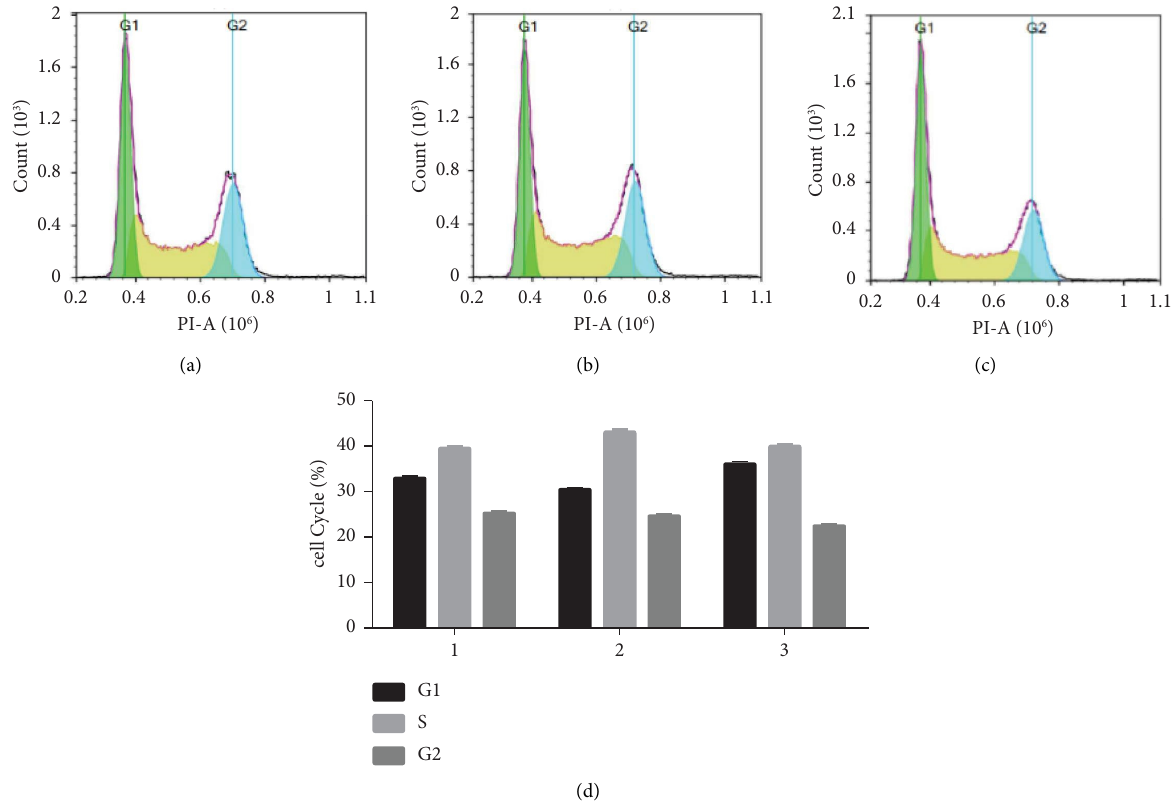
Figure 9: Flow cytometry analysis of HGC-27 cells. From left to right, the SLC concentrations were 0, 2, and 4g/L. Each group was treated with SLCs for 48h. HGC-27 cells were arrested in G1/S phase because of ingredients of